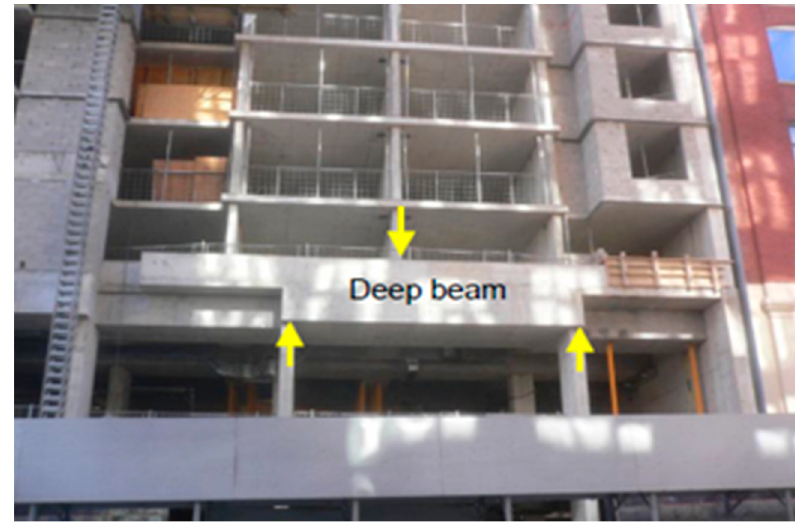
Figure 1. Deep Beam in a multi-story building [2].